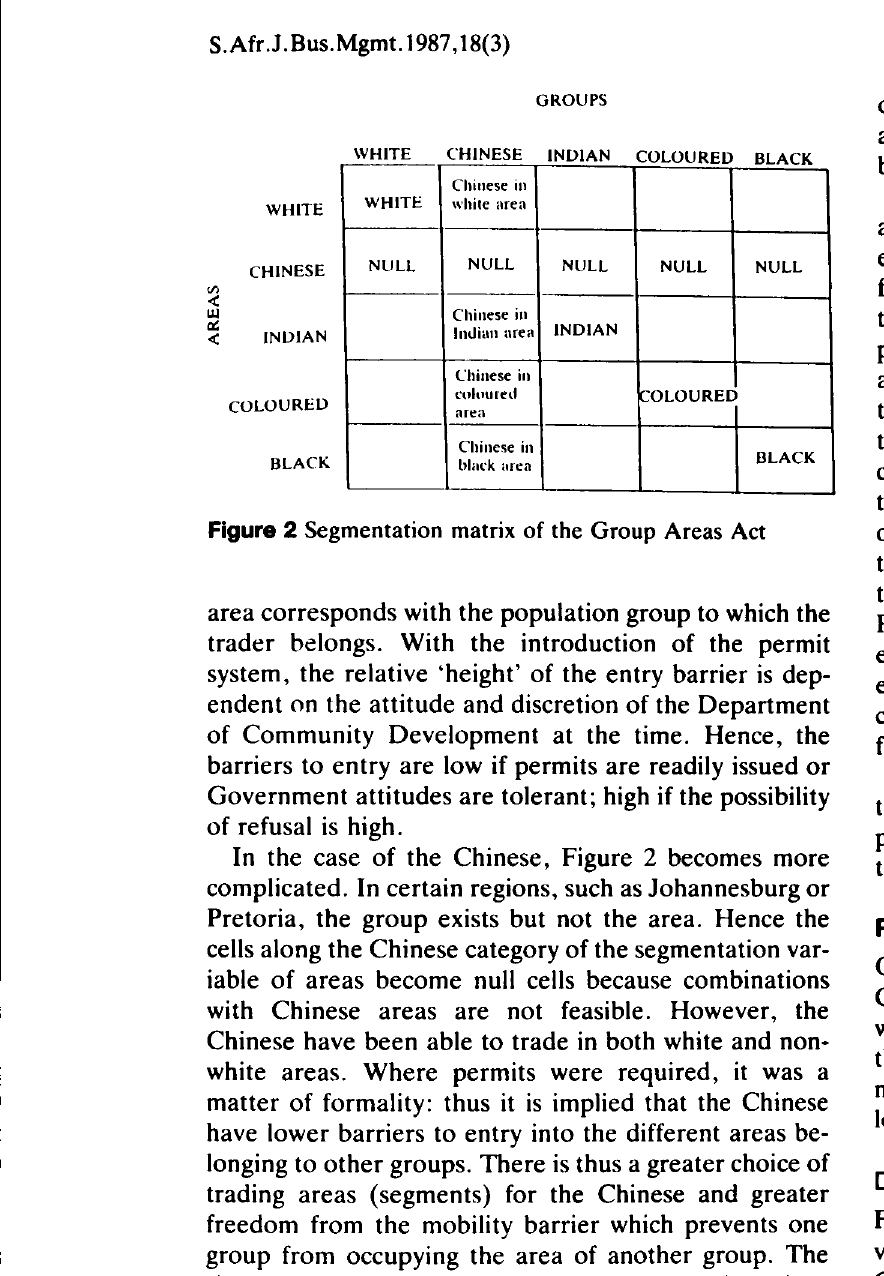
Figure 2 Segmentation matrix of the Group Areas Act